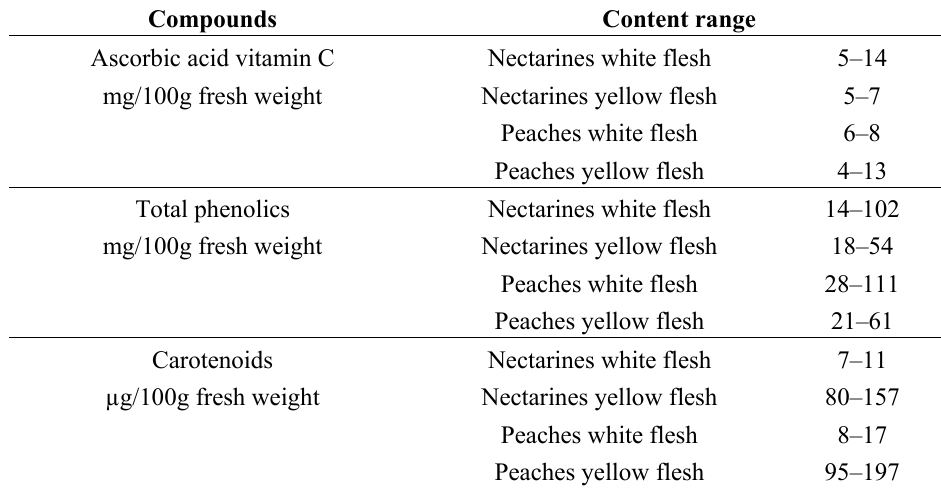
Table 4. Antioxidant molecule contents in ripe fruit (flesh and peel) of peach and nectarine differing for flesh color. Modified from Gil et al.